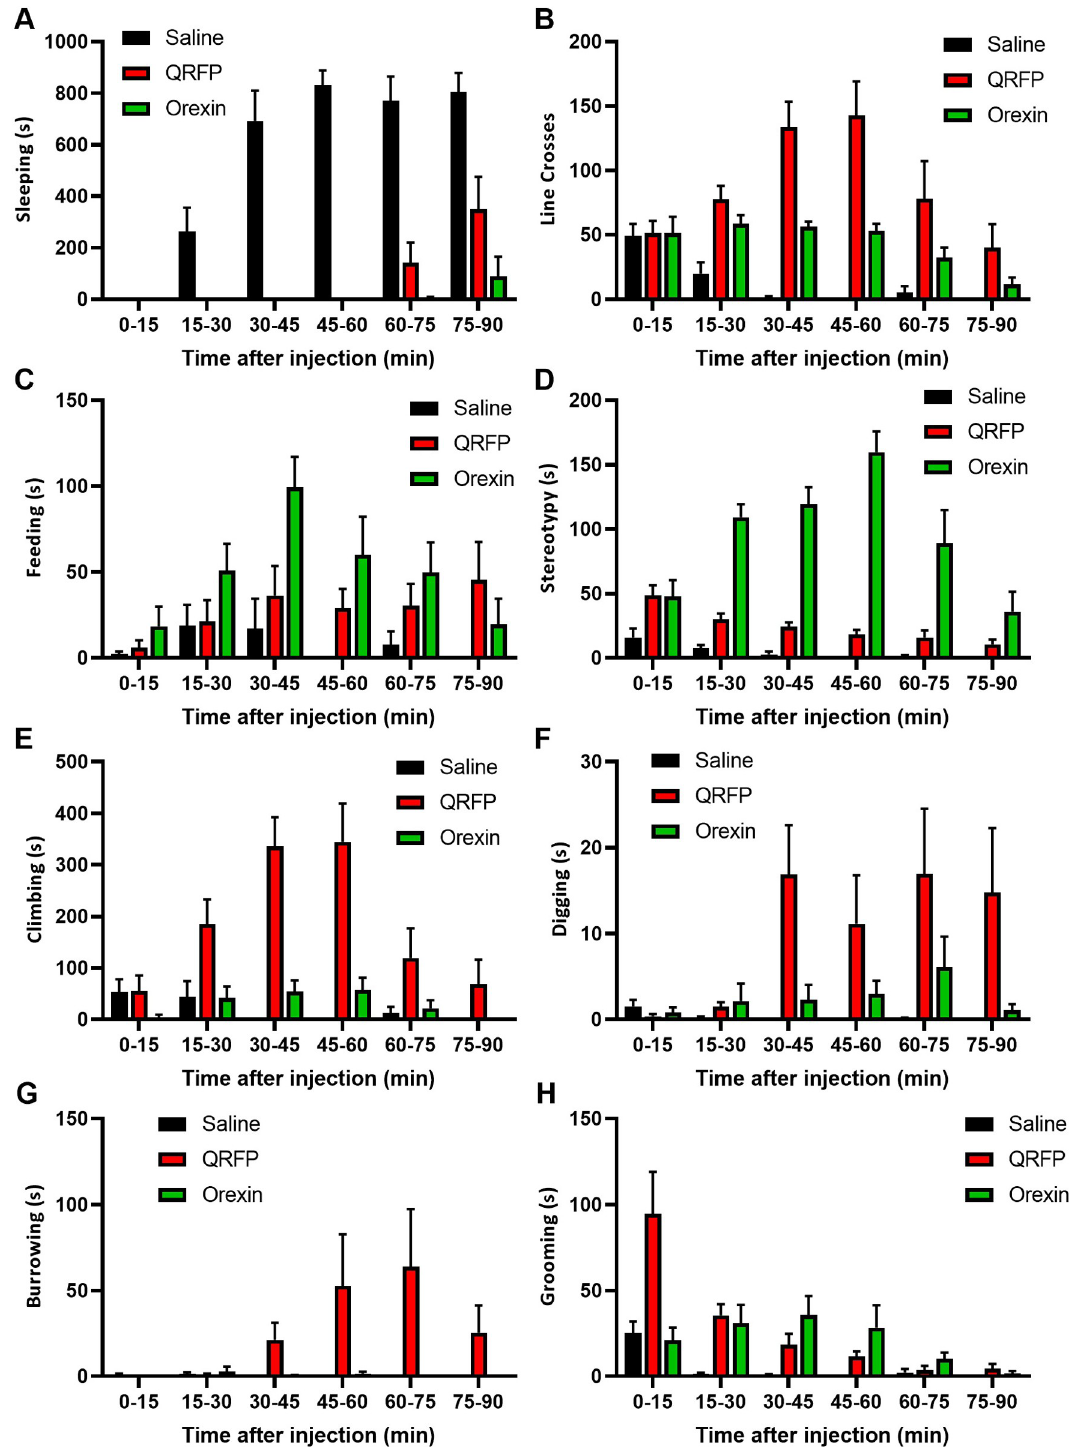
Fig 6. A comparison of the behavioural effects of ICV QRFP and orexin. (A) ICV injection of saline, QRFP or orexin during the day all woke up mice during their normal quiescent period. Saline-treated mice quickly settle down to sleep again. (B) Both peptides increased locomotor activity (line crosses) over the 90-minute observation period. QRFP and orexin had differing effects on behaviours, including (C) feeding, (D) stereotypy, (E) climbing, (F) digging, (G) burrowing and (H) grooming.